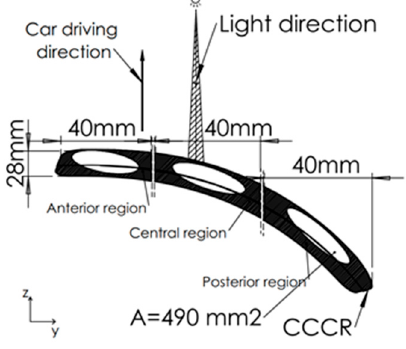
Figure 11. Test regions of CCCR; each testing area is 490 mm 2 .